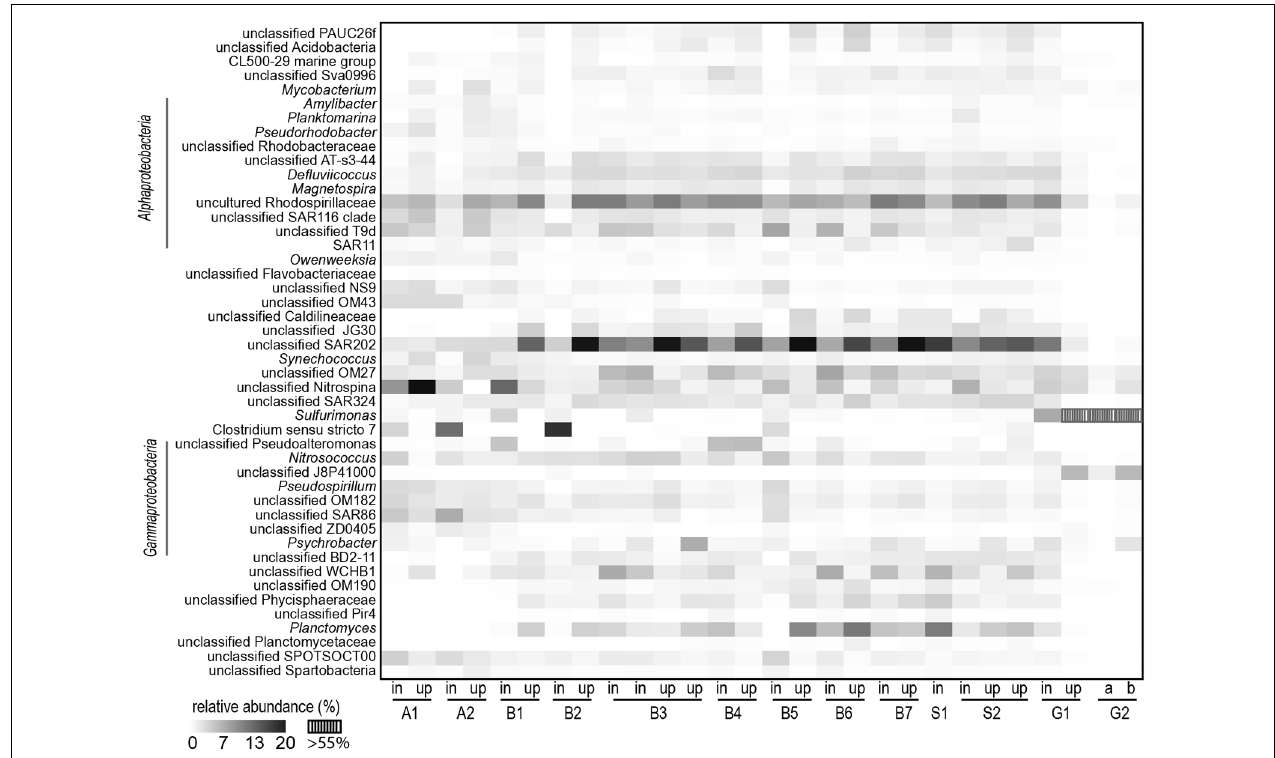
FIGURE 7 | Heatmap of the abundant (total relative abundance > 0.5%) OTUs, based on the rRNA analysis, found in the inflow and uplifted water samples of all stations.